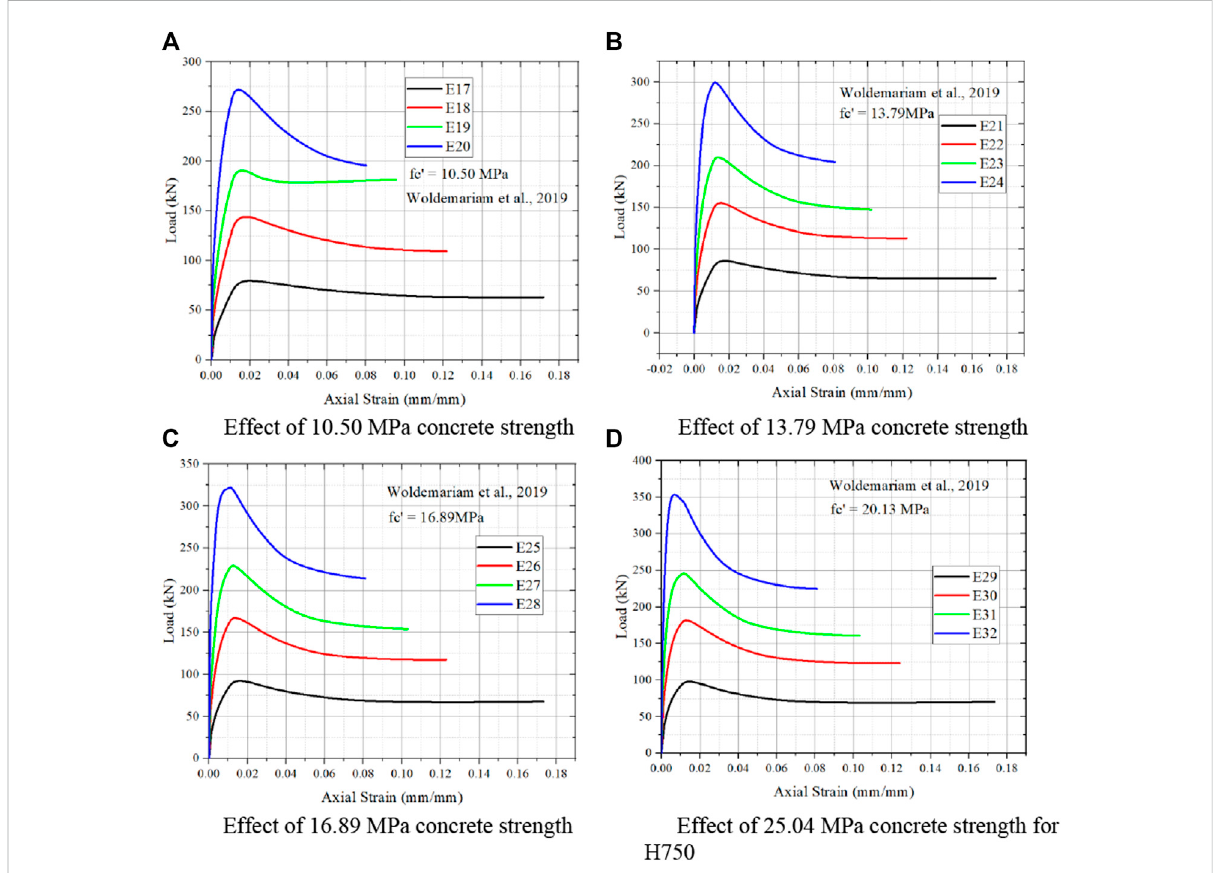
FIGURE 8 EffectofdifferentconcretestrengthfromWoldemariametal.(2019). (A) Effectof10.50 MPaconcretestrength. (B) Effectof13.79